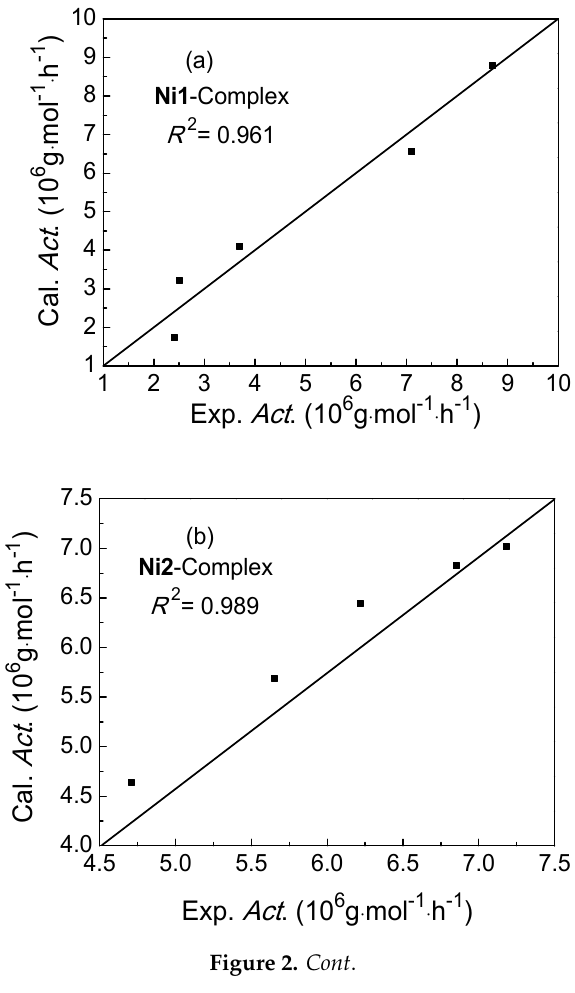
Table 8. Correlation coefficient ( R 2 ) values for Ni1 ‒ Ni2 analogue system for selected combinations of four, three, two and one